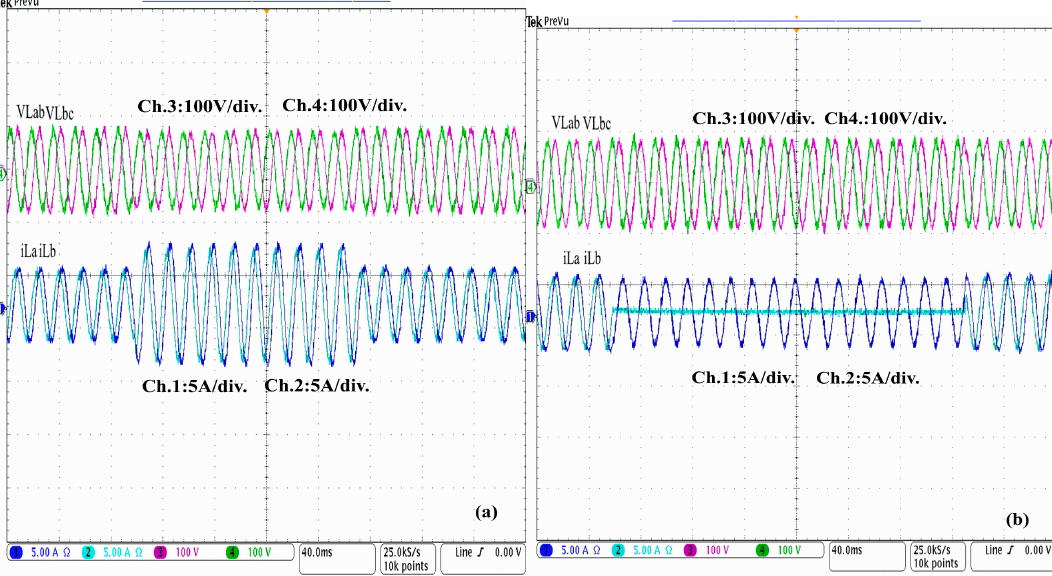
Figure 19. Test results of AWPRC for PCC voltage regulation under ( a ) sudden load variation, and ( b ) unbalanced linear load.